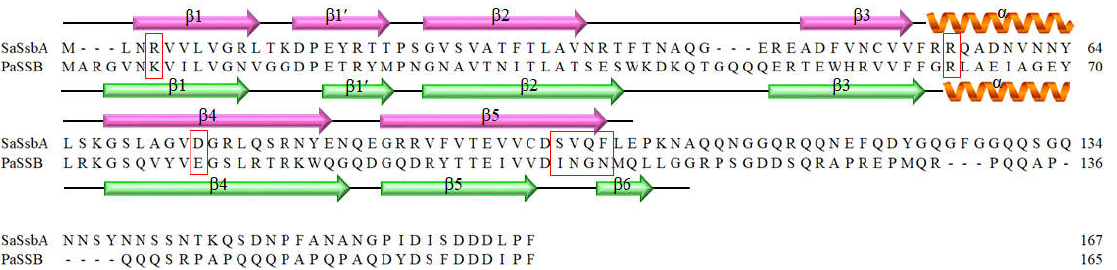
Figure 3. Sequence alignment of SaSsbA and PaSSB. Residues Lys7, Arg62, Glu80, Ile105, Asn106, Gly107, and Asn108 in PaSSB are involved in myricetin binding. The corresponding residues in SaSsbA are indicated by red boxes. Only Arg56 in SaSsbA was conserved as a possible site for myricetin binding. The secondary structural elements of SaSsbA and PaSSB are shown with the sequences.